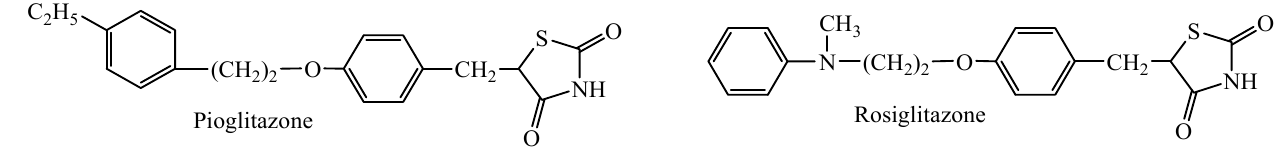
Figure 1. The structure of pioglitazone and